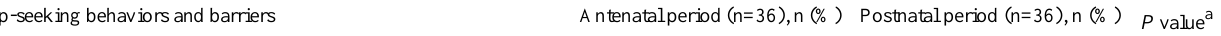
Table 4. Help-seeking behaviors and barriers to help seeking in the month before completing the study survey among antenatal and postnatal Whooley-positive